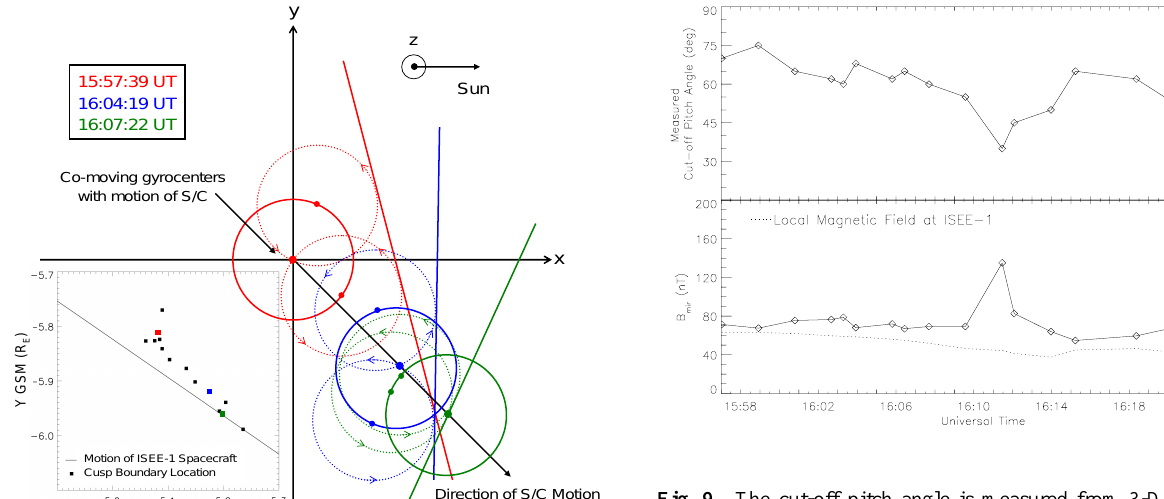
Fig. 9. The cut-off pitch angle is measured from 3-D PAD (top panel), where the s/c almost never observes particles with pitch an- gles less than 30 degrees. The magnitude of the corresponding mir- ror points for these particles are plotted in the bottom panel,where these values are approximately that of the LMF present outside the CDC ( ∼